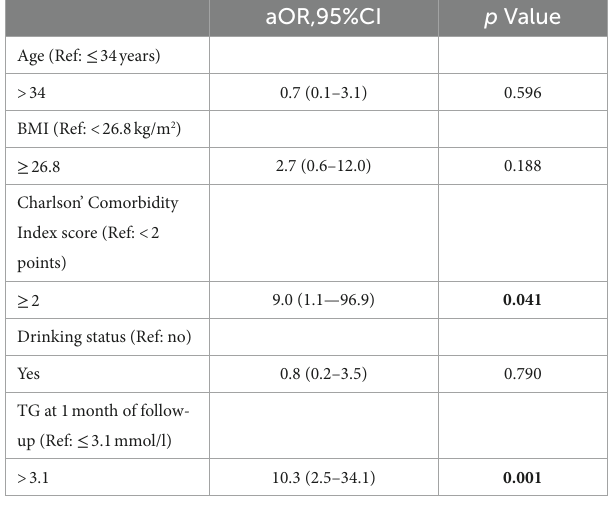
TABLE 4 Univariable logistic regression analysis for recurrence in patients with HTGP.